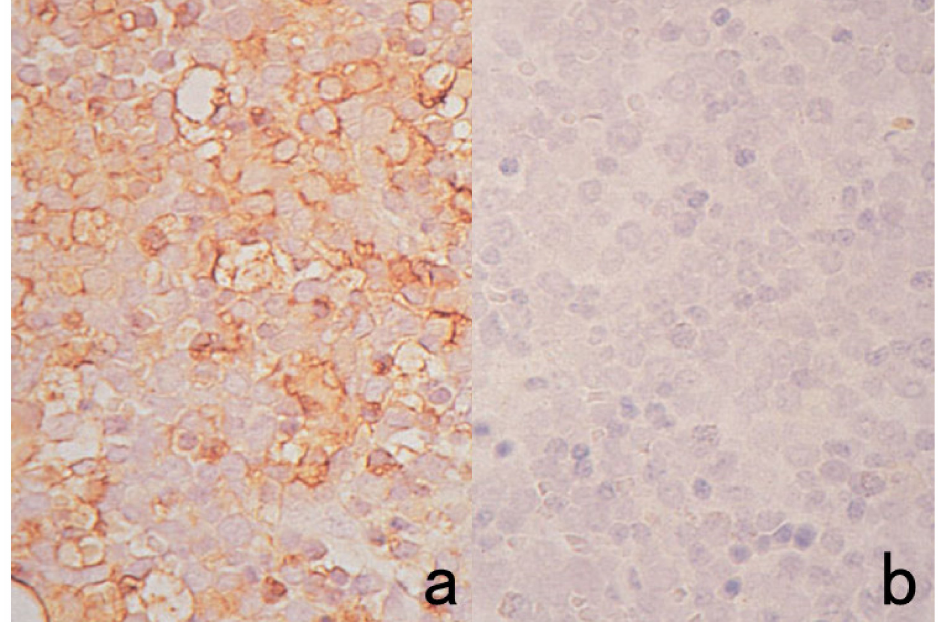
Figure 40. Antigenic loss by HIER in 10 mM citrate buffer, pH 6.0. BM-1 (a myeloid marker) in FFPE bone marrow aspiration. ( a ): Without HIER and ( b ): after HIER with pressure pan heating at 121 ◦ C for 10 min. BM-1 immunoreactivity is quite susceptible to the heating